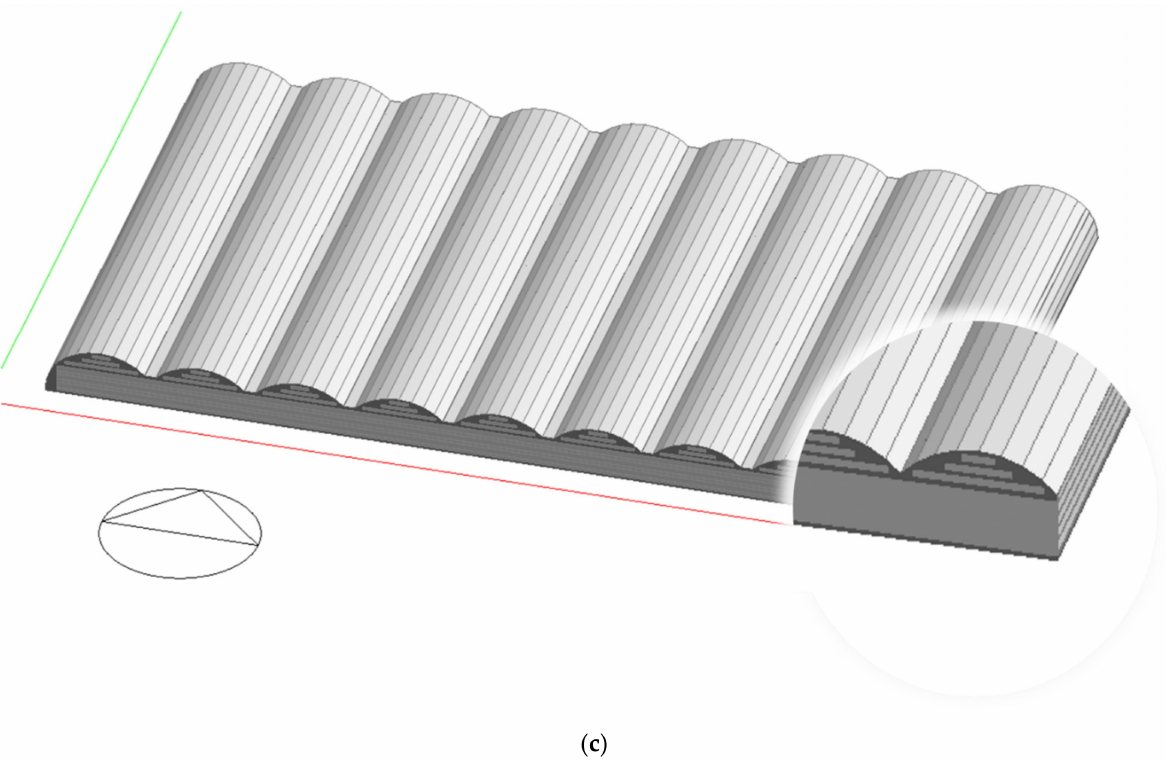
Figure 10. Simulation models of three types of greenhouses. ( a ) Crossed multi-arch greenhouse; ( b ) Multi-span round-arch greenhouse with an in-greenhouse ventilation channel; ( c ) Multi-span round-arch greenhouse without an in-greenhouse ventilation